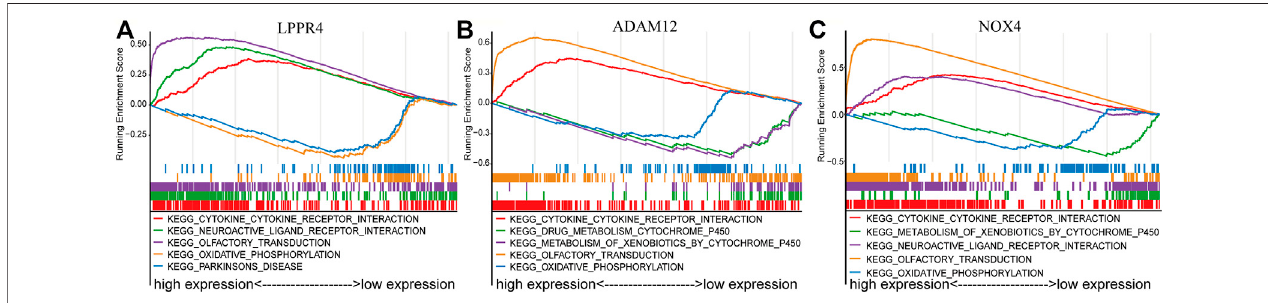
FIGURE 5 | GSEA enrichment analysis of three signature genes related to TME. The top fi ve most signi fi cant pathways were shown for each gene. (A) LPPR4. (B) ADAM12. (C)